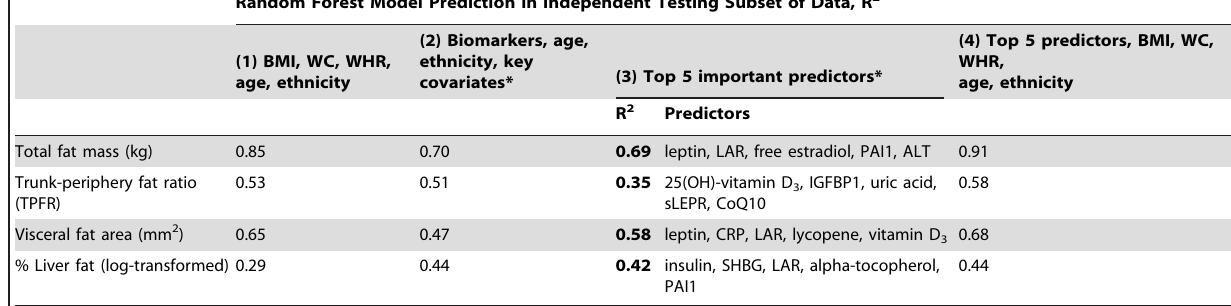
Random Forest Model Prediction in Independent Testing Subset of Data, R